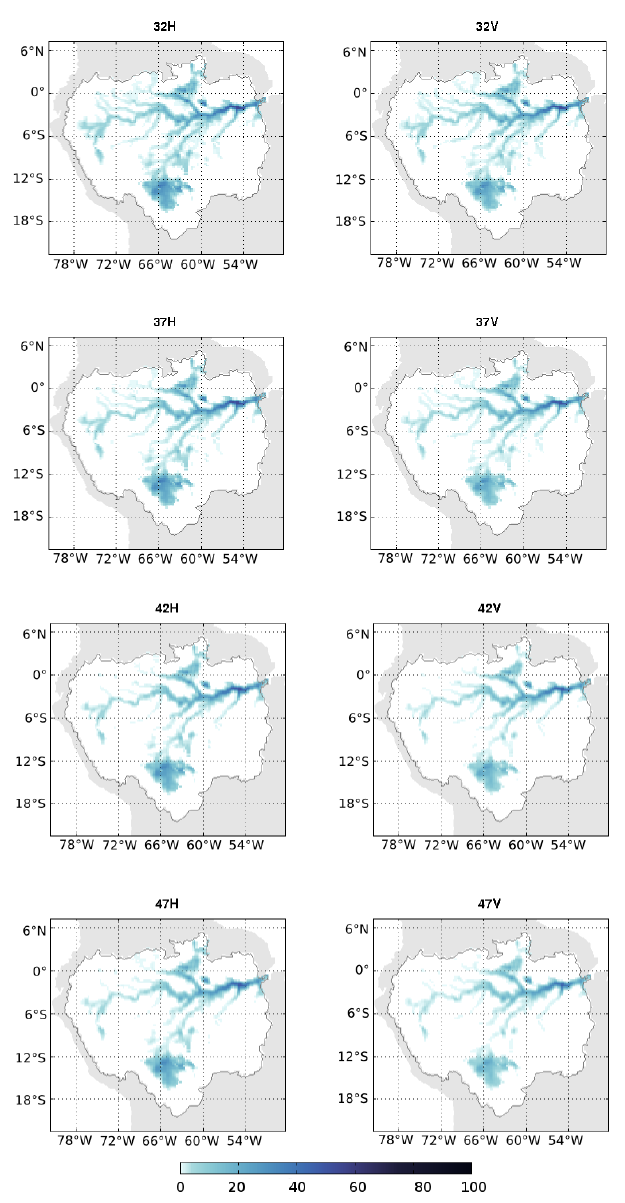
Figure 5. Average in time of the SMOS water fraction during 2010–2015 over the full Amazon Basin. Both H and V polarization and the four incidence angles (32 ◦ ± 5 ◦ , 37 ◦ ± 5 ◦ , 42 ◦ ± 5 ◦ , 47 ◦ ± 5 ◦ ) are considered.